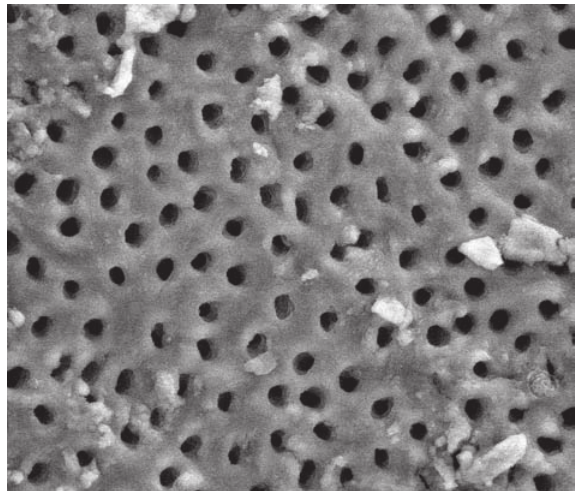
Figure 3- Presence of smear layer in root canals following root canal irrigation treatments. The presence of smear layer criterion is shown as a percentage of root canals for each of the irrigation treatments